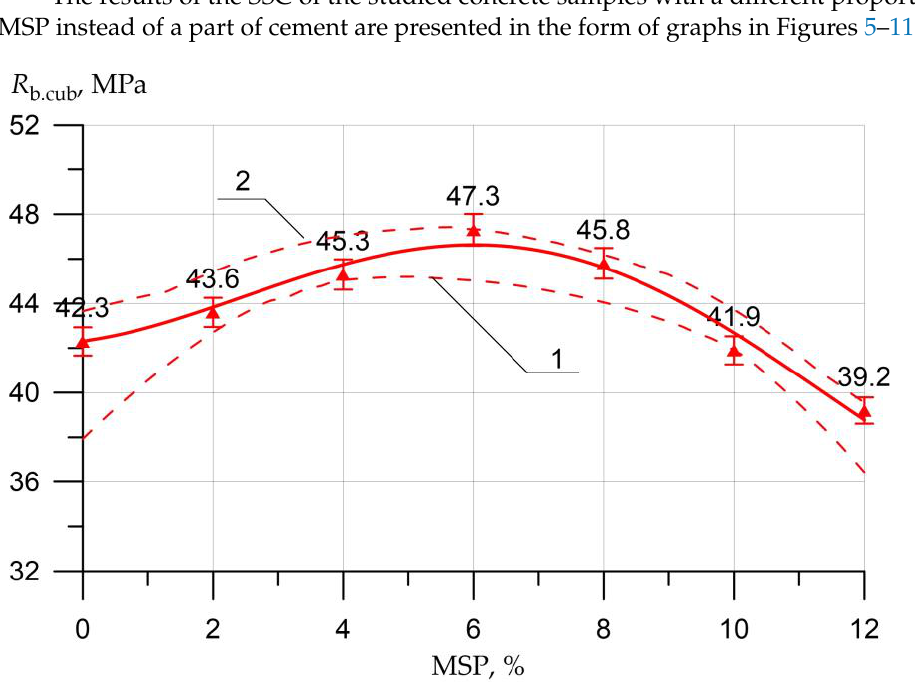
R on the amount of MSP: 1 — lower confidence level;